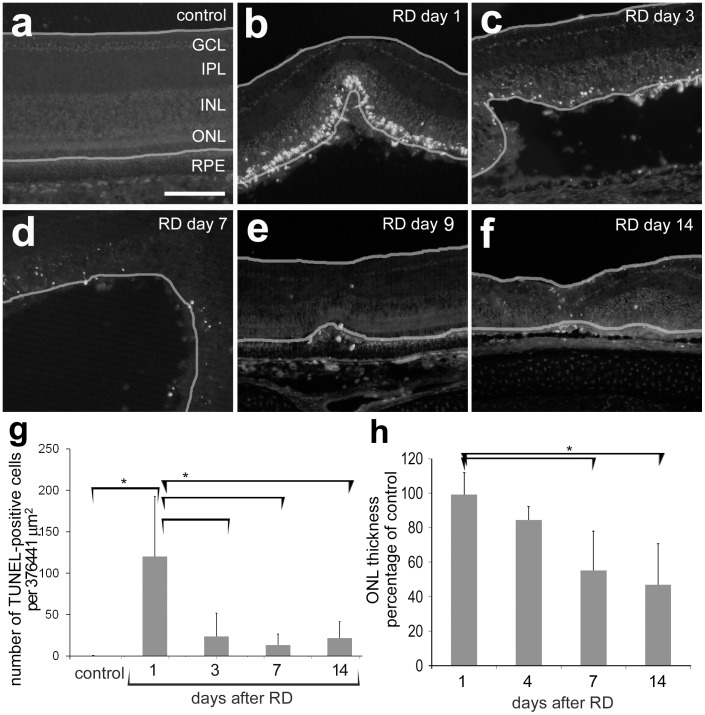
Photoreceptor cell death in chick RD.(a–f) Representative photographs of TUNEL-positive cells in control retina and day 1, 3, 7, 9 and 14 HA RDs. TUNEL positive cells are more prevalent in the outer nuclear layer early after detachment. The yellow lines mark the inner and outer limiting membranes. (g) Quantification of TUNEL: a bracket with an asterisk marks statistically significant differences between control and day 1 (p<0.0001) as well as day 1 and day 3 (p<0.0001), day 7 (p<0.0001), and day 14 (p = 0.0004). (h) Quantification of outer nuclear layer thickness: a bracket with an asterisk marks statistically significant differences between day 1 and day 7 (p = 0.0005) and day 14 (p = 0.0033). Error bars represent standard deviation.